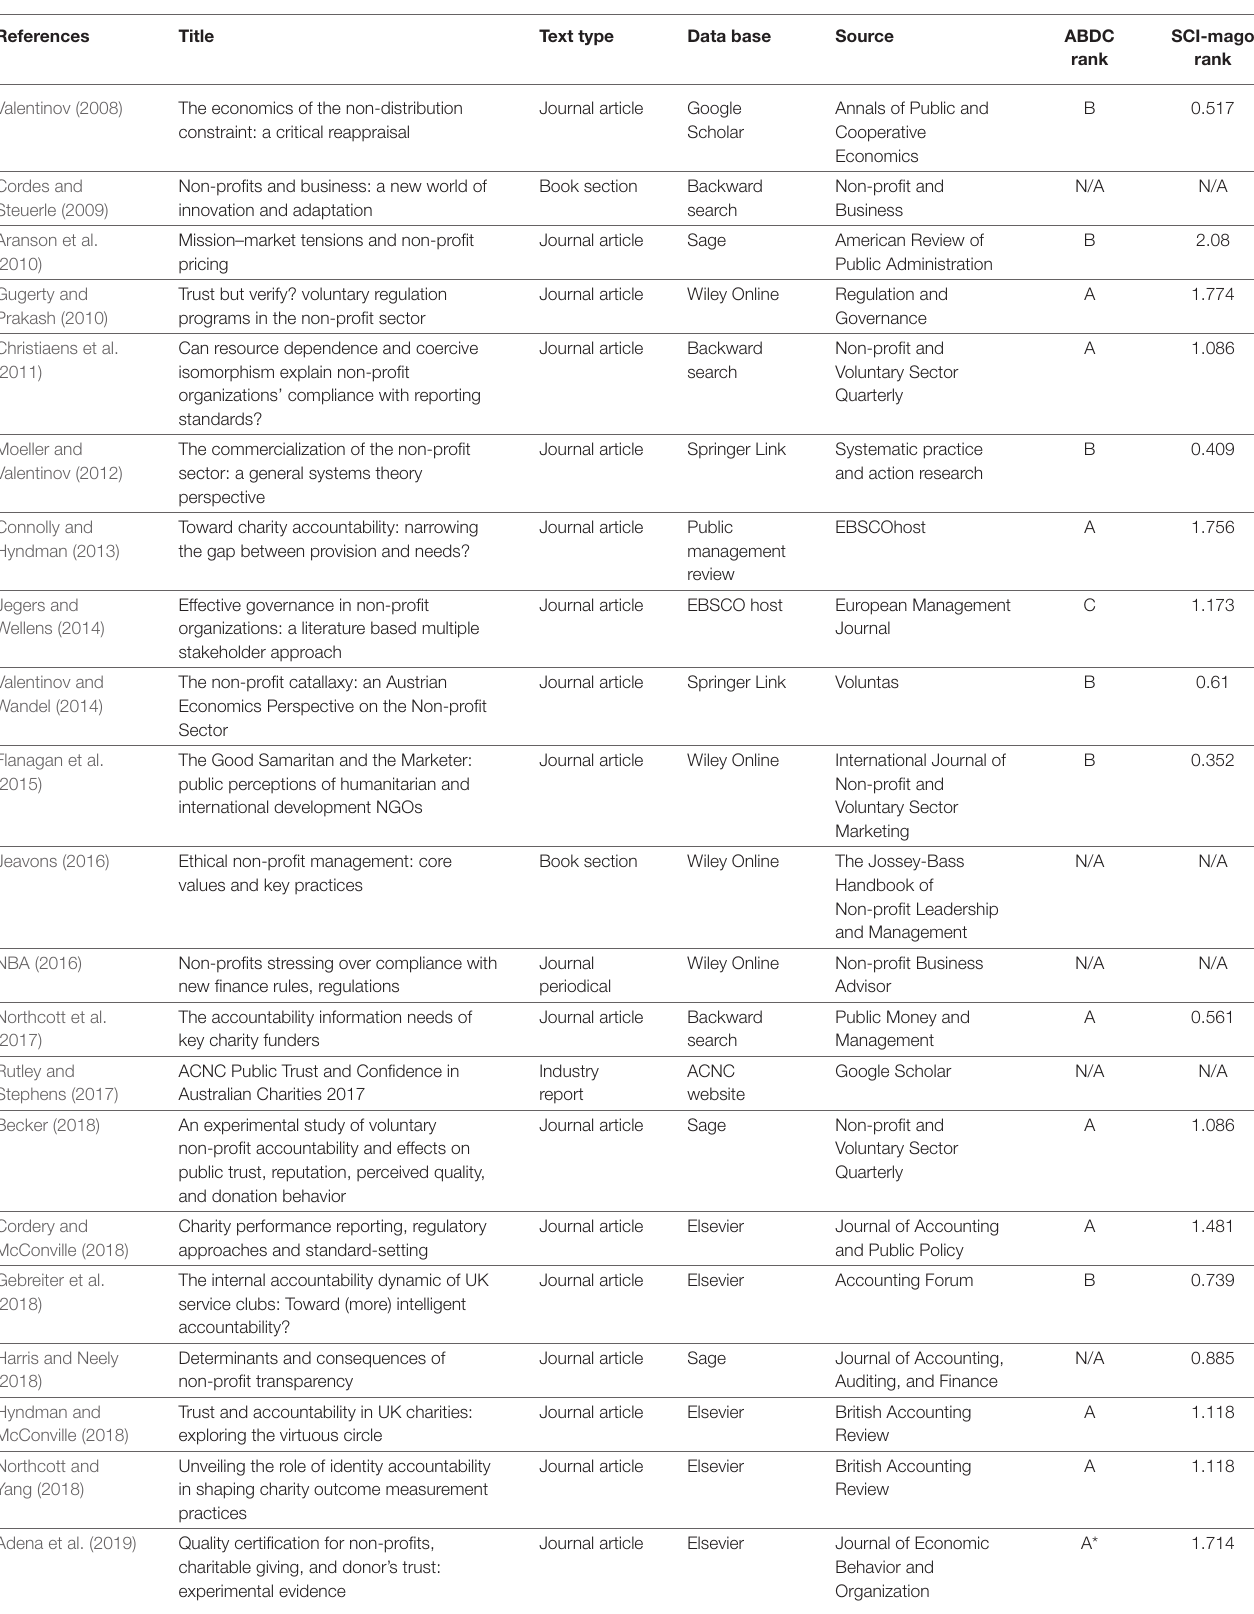
TABLE 2 | Shortlisted literature (Group